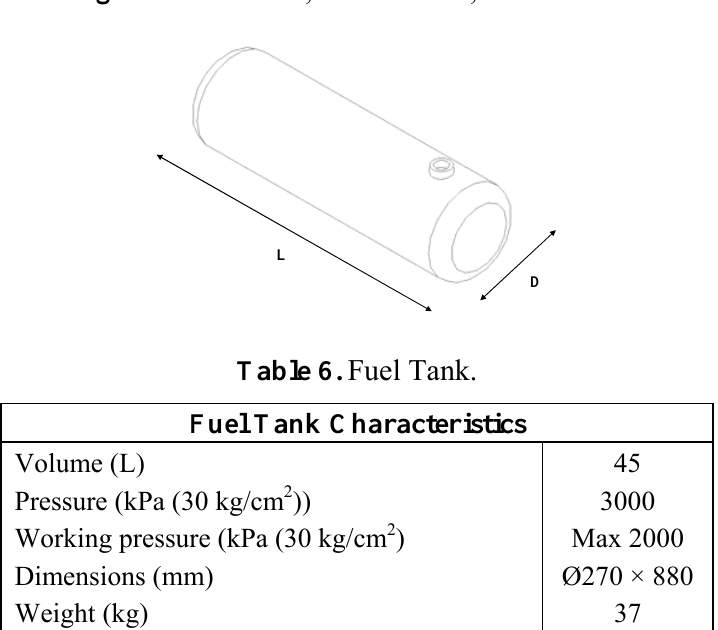
Figure 7. Fuel tank; L = 880 mm, D = 270 mm.